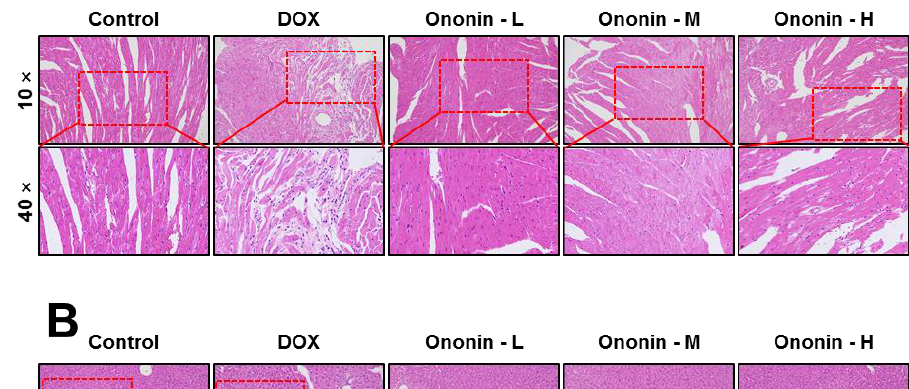
Figure 11. Biochemical index of animals after ononin treatment . The levels of ALT and/or AST in different groups were determined, and values are expressed as the fold of changes (X basal), in Mean ± SEM, with n = 6.